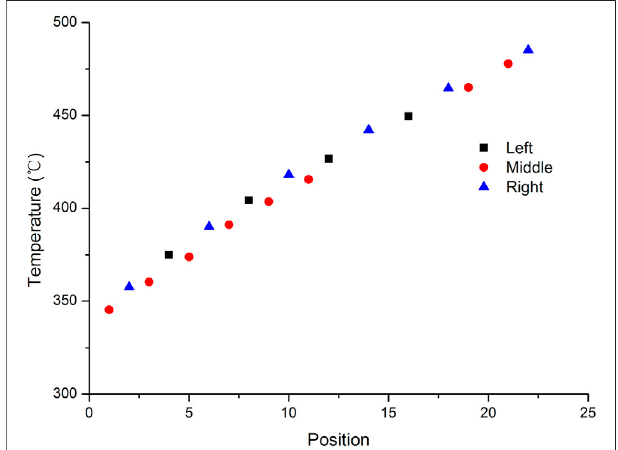
FIGURE 5 | Wall temperature under rated working condition.